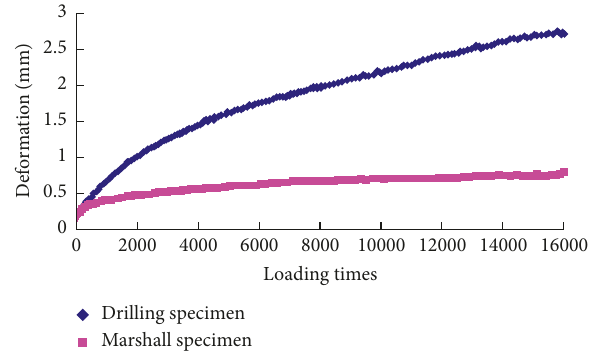
Figure 14: Relation between deformation and loading times.